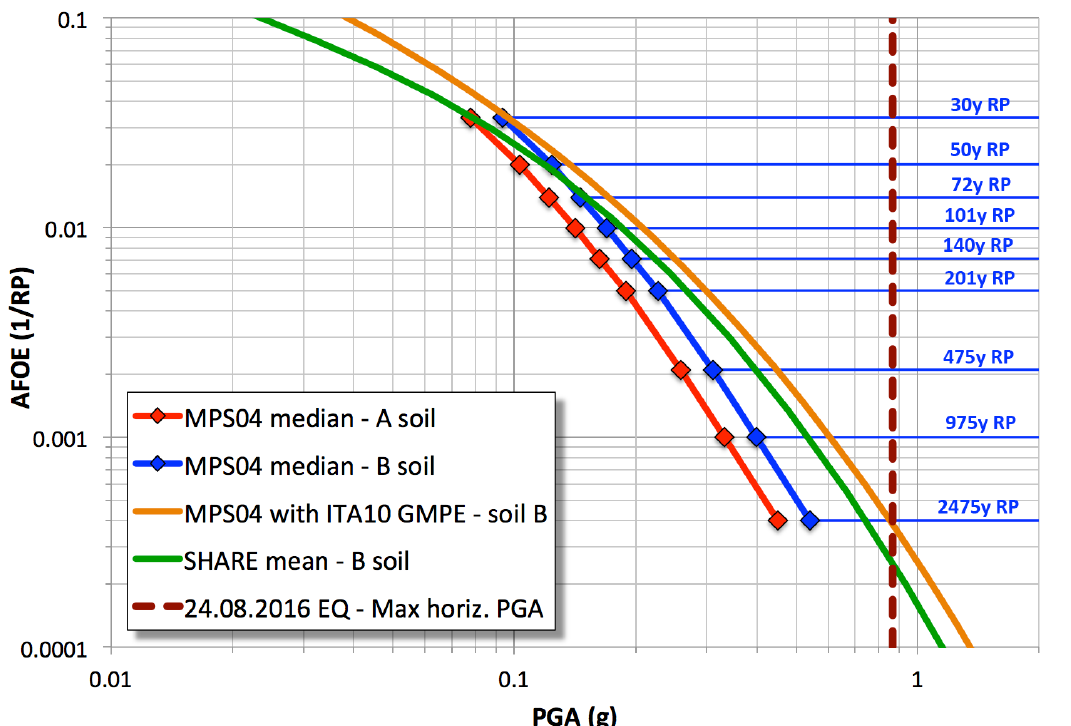
Figure 4. Comparison of the maximum horizontal PGA of the Amatrice Mw 6.0 mainshock recorded at the AMT station with the hazard curves of MPS04 (for soil class A and B), SHARE (for soil class B) and MPS04 modified by using ITA10 GMPE (for soil class B) [Bindi et al., 2011] at the node of the computational grids closest to AMT site. Because we have no data about the return period of the PGA recorded at AMT, it is shown as a vertical line. Potentially, the intersection be- tween this vertical line and the hazard curve returns the approximated return period of that horizontal ground shaking for that site. It is clear from Figure 4 that the MPS04